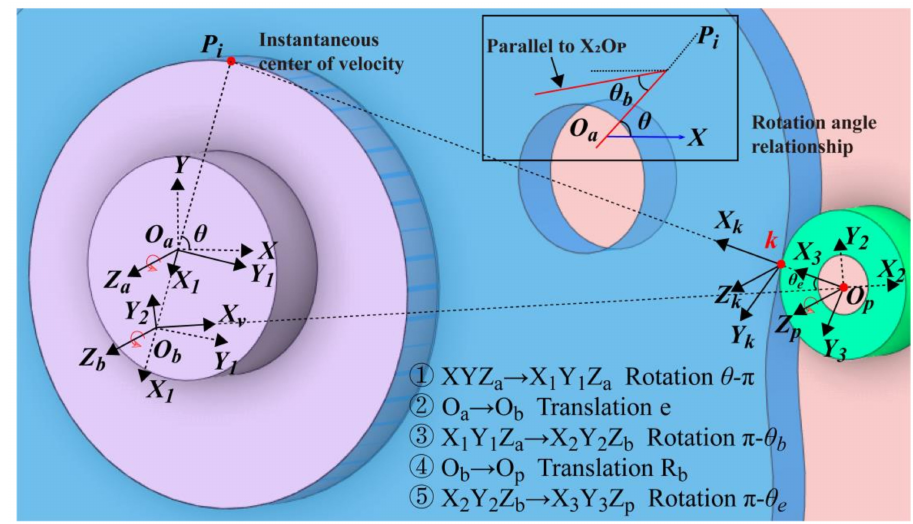
Figure 3. Cycloidal profile single-point coordinate transformation trajectory.